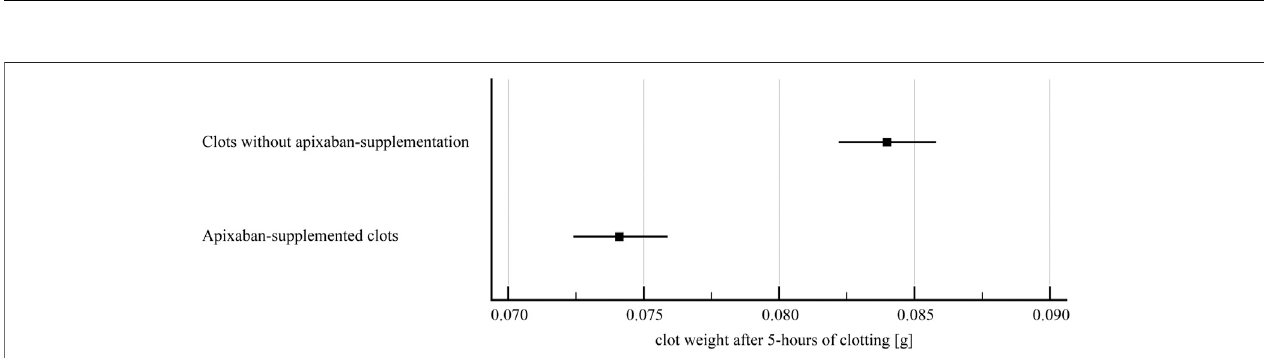
FIGURE 6 | Flow model: clot lysis expressed as red blood cell release into incubation media. The forest plot shows mean values (square) and 95% con fi dence interval (whiskers). n (cid:1) 9 – 10. Results demonstrate that alteplase treatmentprovidedef fi cient thrombolysis, e.g. documented as greater red blood cell release compared to untreated group (0.029 ± 0.007 vs. 0.012 ± 0.007, p < 0.01). For clots with and without apixaban, alteplase-induced lysis marginally increased red blood cell release for clots without apixaban (0.022 ± 0.007 vs. 0.029 ± 0.007, p (cid:1) 0.16). See Supplementary Table S3 for more details.